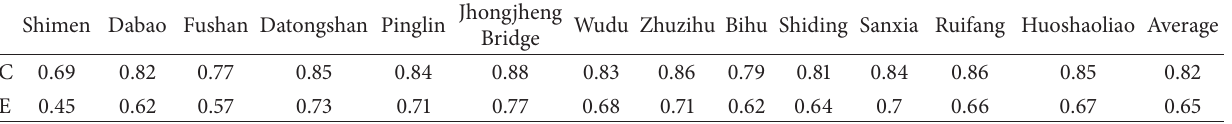
Table 5: Coefficients of correlation and efficiency during Typhoon Dujuan